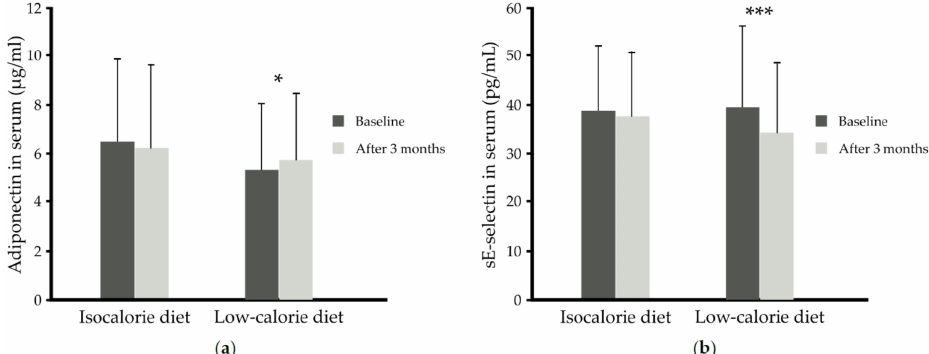
Figure 5. ( a ) Serum adiponectin ( µ g/mL) before and after 3 months of isocaloric diet ( n = 27) intervention or before and after 3 months of low-calorie diet ( n = 37) intervention independent of supplementation, ( b ) Serum sE-selectin (pg/mL) before and after 3 months of isocaloric diet ( n = 27) intervention or before and after 3 months of low-calorie diet ( n = 37) intervention independent of supplementation. Data are shown as means ± SD. Statistics: analyses were performed with repeated measures by ANOVA and Tukey post hoc test; significance: * p < 0.05 after versus before low-calorie diet, *** p < 0.001 after versus before low-calorie diet. With regards to proinflammatory markers, IL-6, MCP-1 and CRP were not significantly